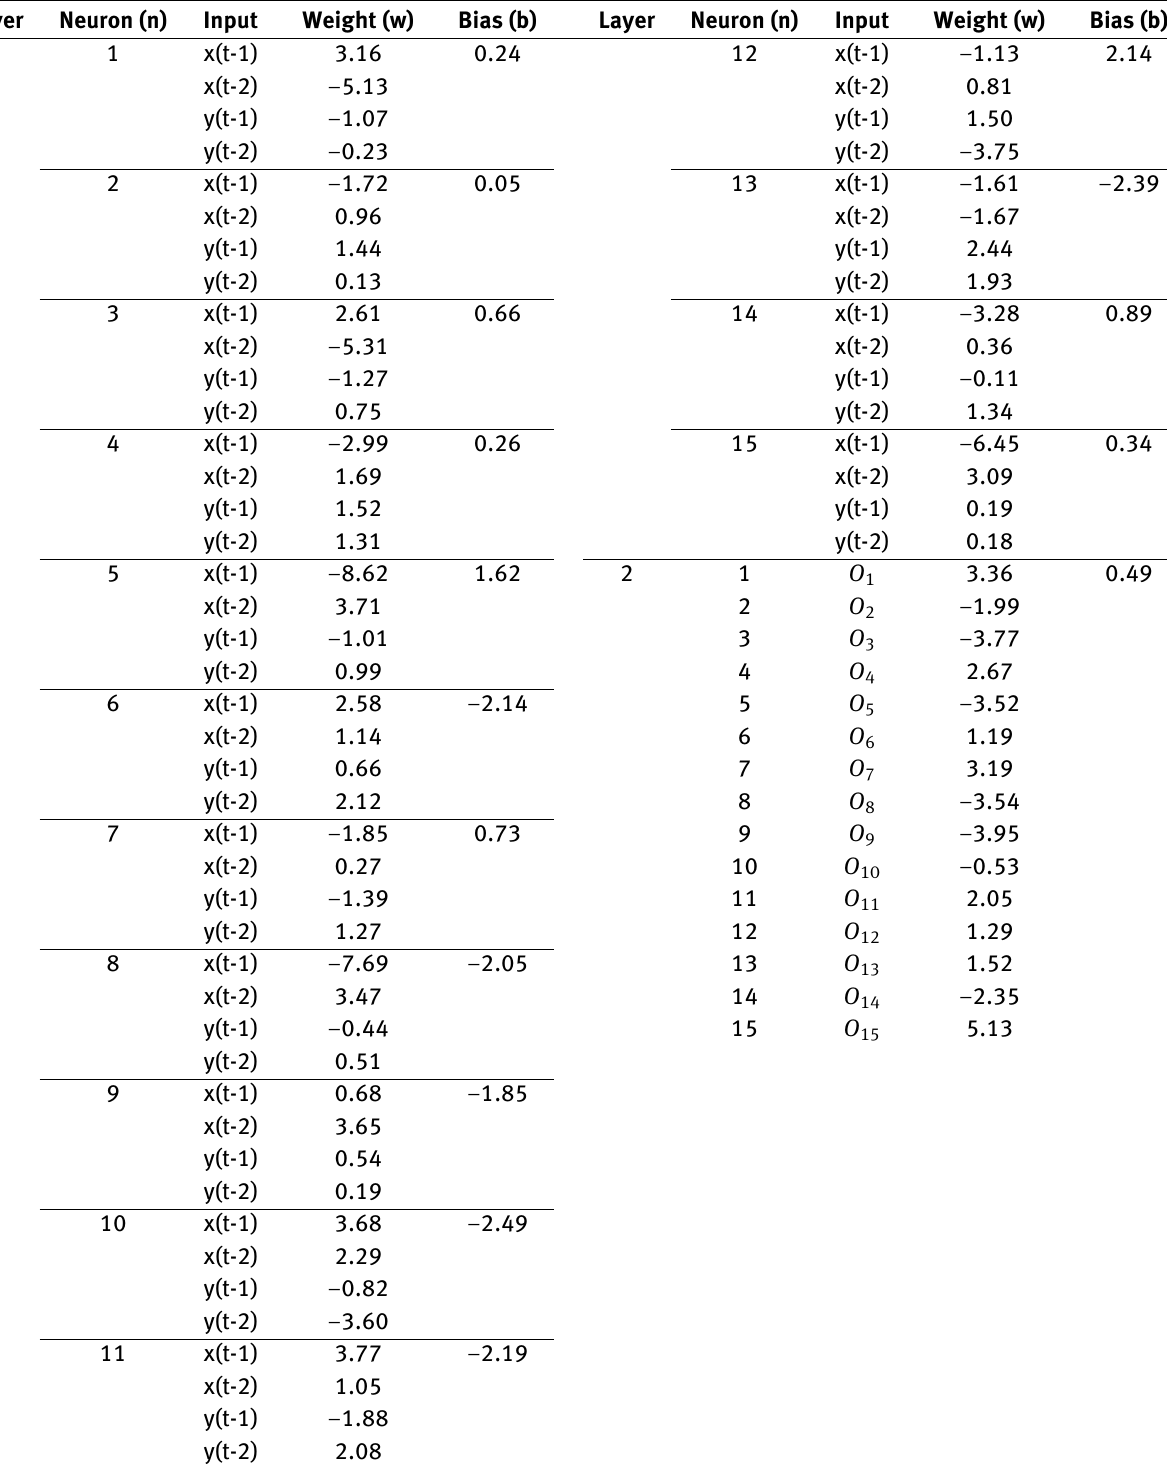
Table 1: Weight and bias of the trained network